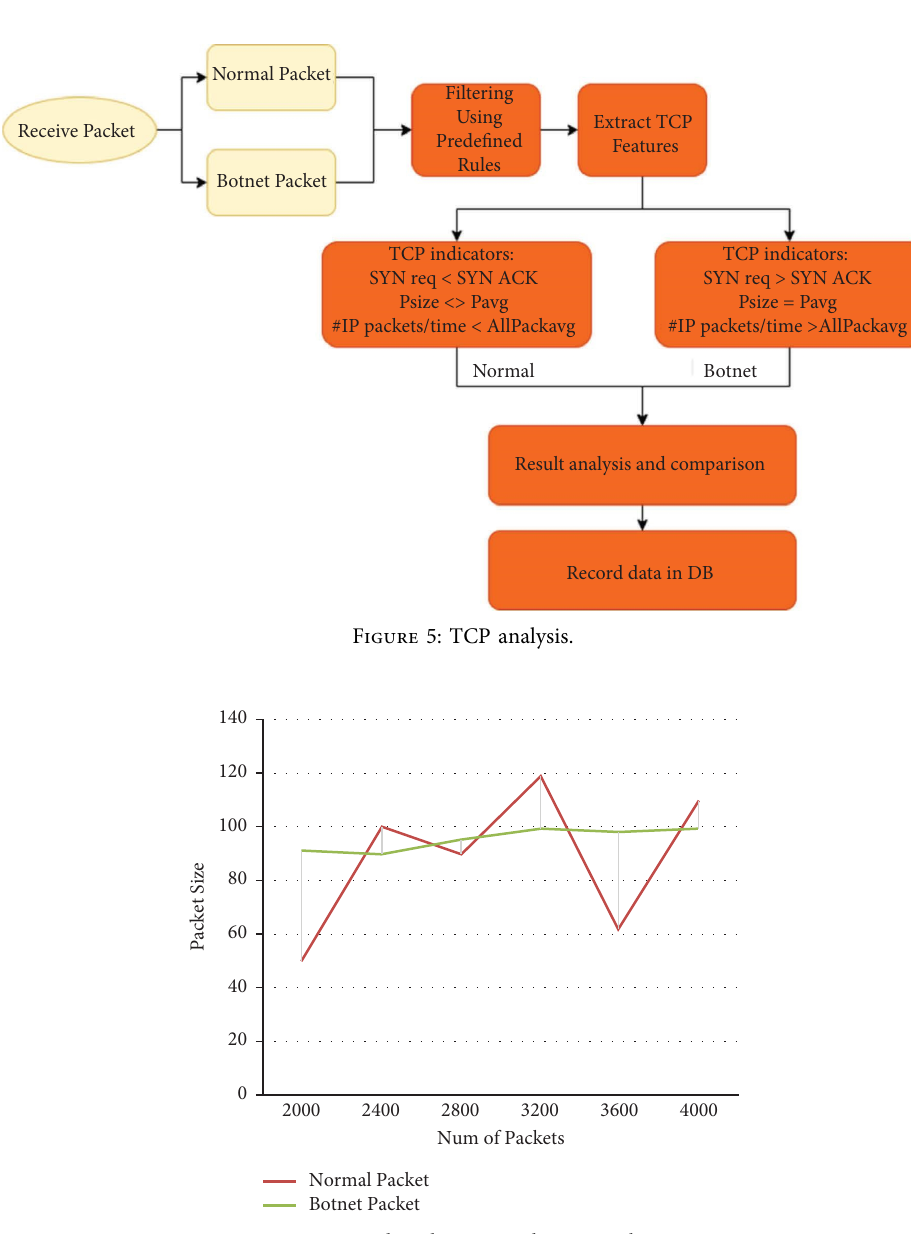
Figure 6: Normal packet size vs botnet packet